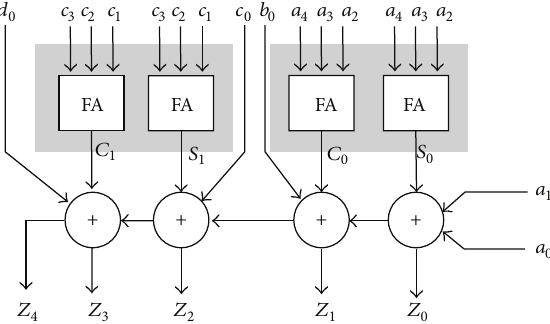
Figure 2: Mapping of (1,4,1,5;5) GPC to Altera Stratix IV from [1], claimed to use two LUTs.